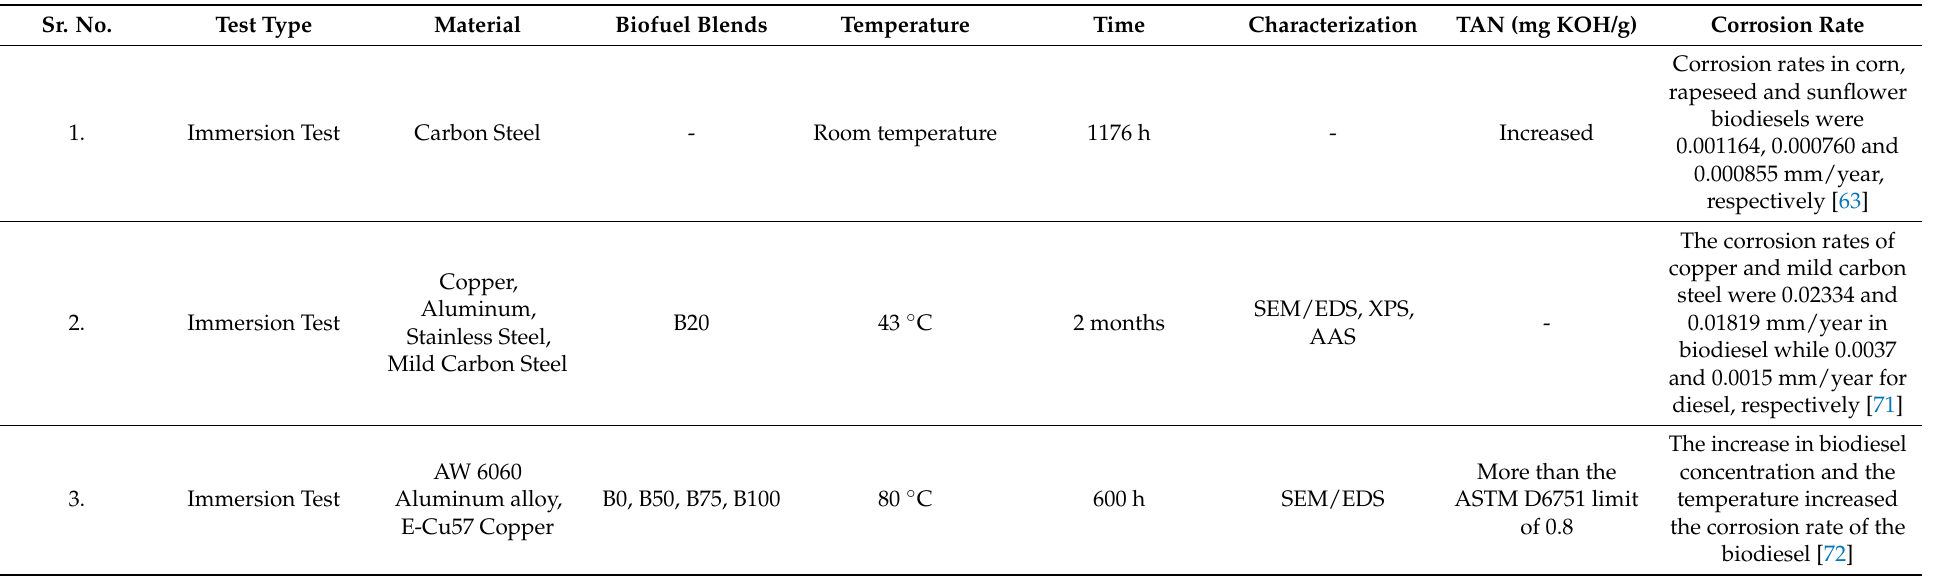
Table 3. Summary of corrosion studies using rapeseed